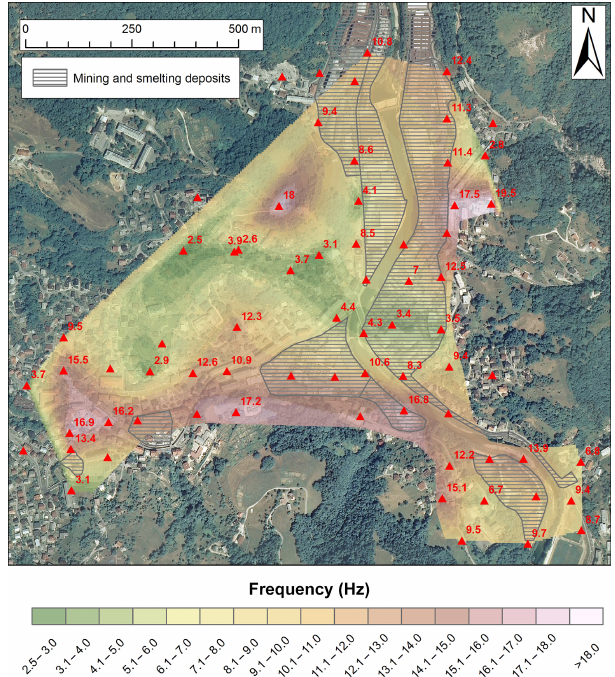
Figure 8. Map of the sediments main resonance frequency in the Idrija town area derived from microtremor measurements. Trian- gles indicate points of all measurements. Corresponding labels indi- cate the resonance frequency for locations with sufficient HVSR re- sponse. Basemap is digital orthophoto image (Surveying and Map- ping Authority of the Republic of